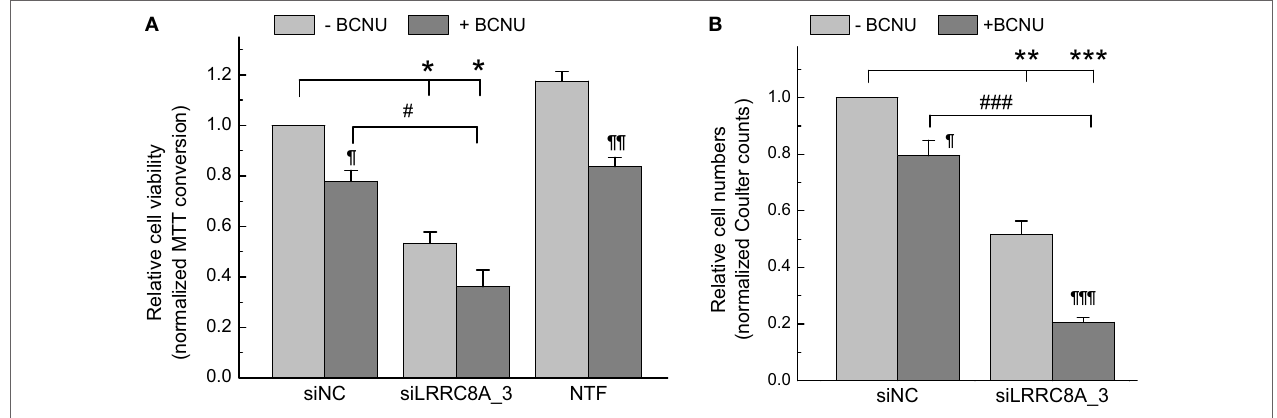
FigUre 4 | Effects of carmustine [bis-chloroethylnitrosourea (BCNU)] and leucine-rich repeat-containing 8A (LRRC8A) siRNA viability and proliferation of glioblastoma (GBM) cells determined using 3-(4,5-dimethylthiazol-2-yl)-2,5-diphenyl tetrazolium bromide (MTT) (a) or Coulter counter (B) assays. GBM cells were transfected with siLRRC8A_3 (siA_3) or negative control siRNA (siNC). 48 h post-transfection cells were additionally treated with 167 µM BCNU. Relative levels of cell proliferation were determined 48 h after addition of BCNU (96 h post-transfection with siRNA) using an MTT assay. Non-transfected cells (NTF) were used as an additional internal control in MTT experiments. The data are the mean values ± SE of three independent experiments performed in triplicates ( n = 3) in MTT assays, or four independent transfections ( n = 4) in Coulter counter experiments. * p < 0.05, ** p < 0.01, *** p < 0.001 vs. cells transfected with siNC. ¶ p < 0.05, ¶¶ p < 0.01